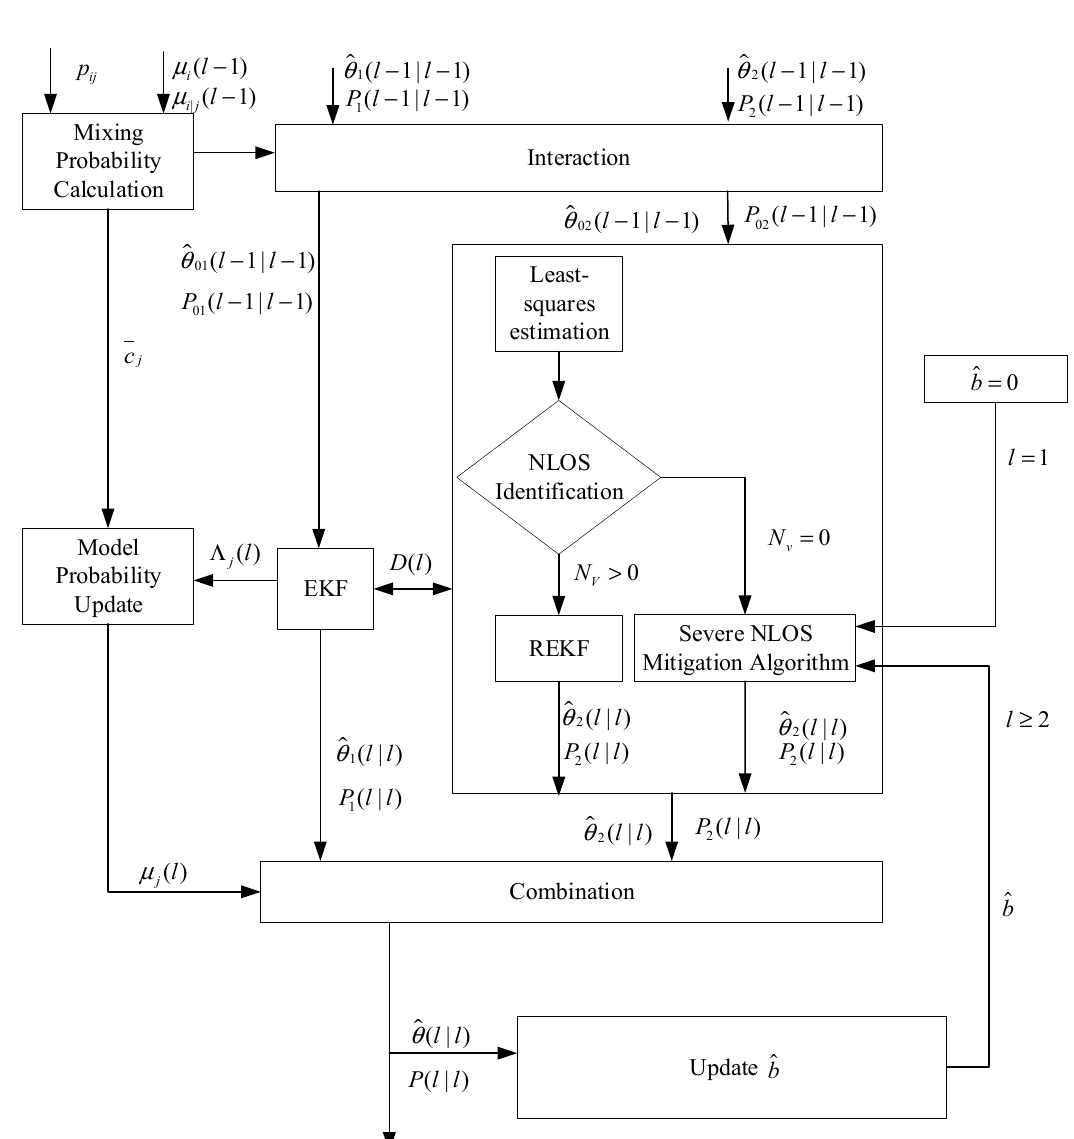
Figure 2. The flowchart of the proposed algorithm.